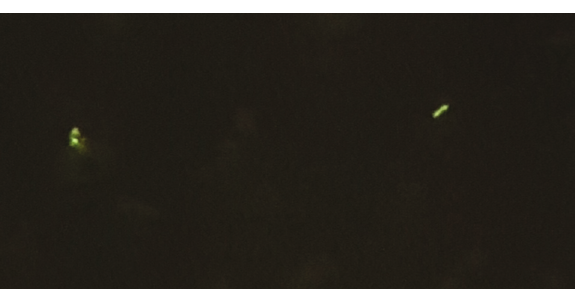
Mycobacteria in Ziehl Neelsen Stain (ZN stain, x1000). Fig. 1: